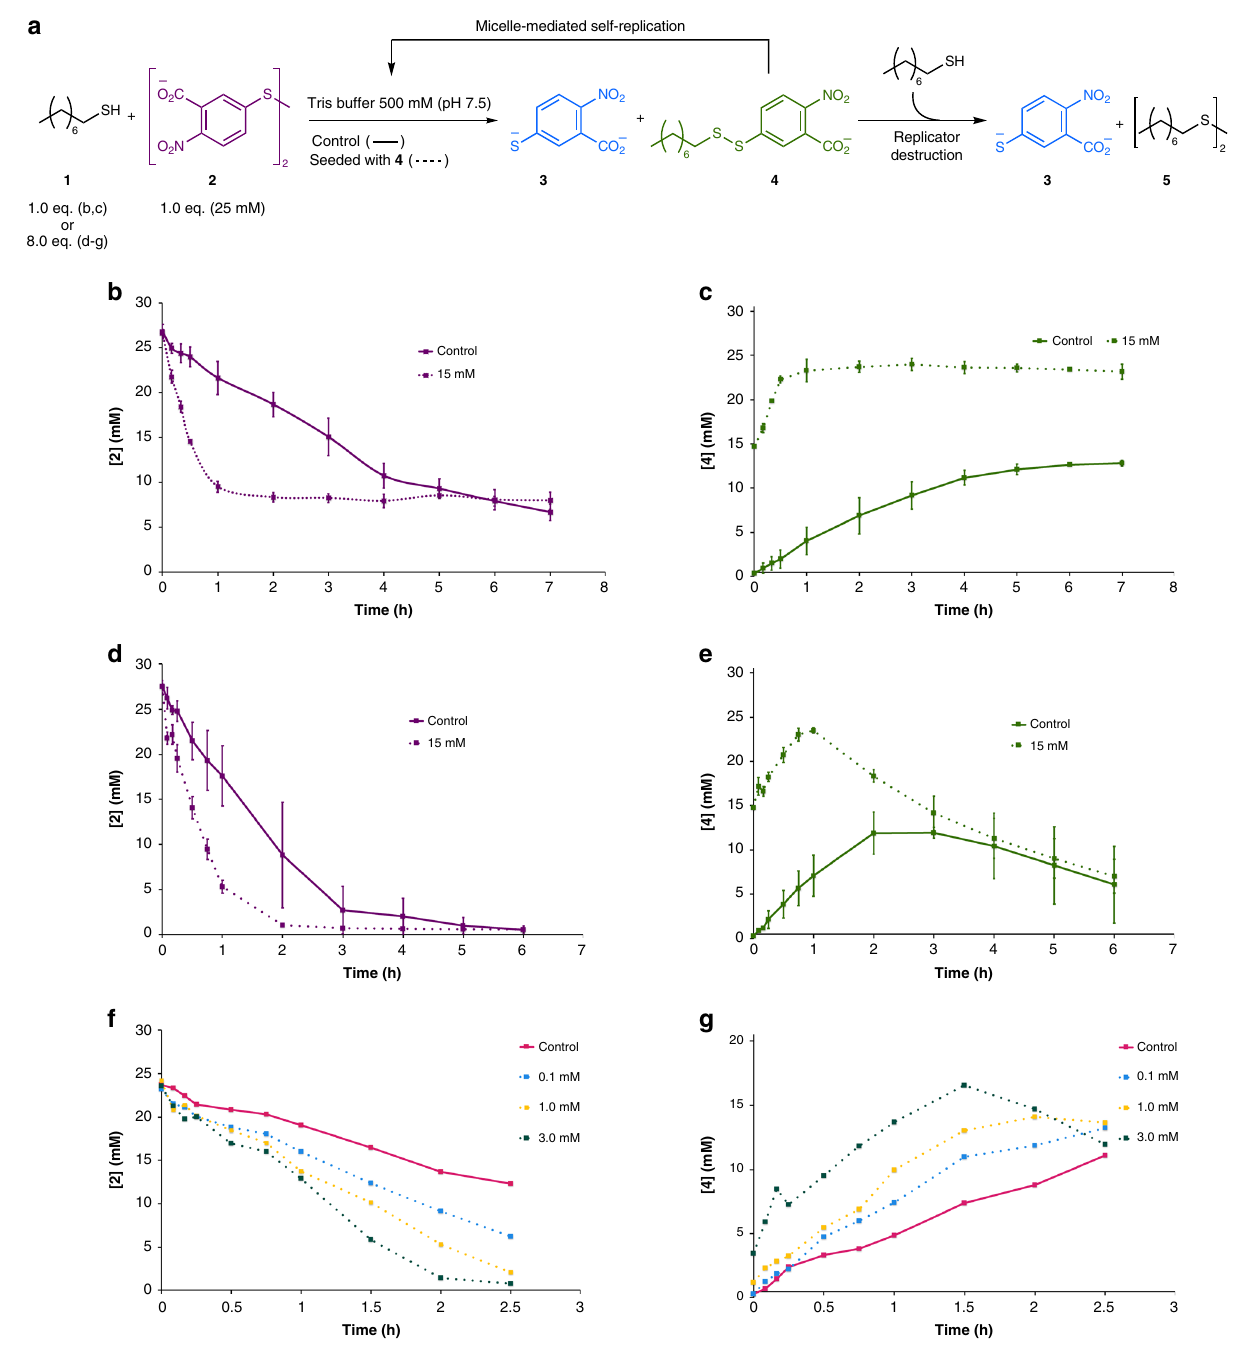
Fig. 3 Control and seeded reactions. a A series of control and seeded reactions were performed to demonstrate autocatalysis, with variation both in the concentration of seeded product 4 and the equivalents of octanethiol 1 . b , c Concentration of 2 and 4 (respectively) over the course of the reaction conducted with 1.0 equivalent of octanethiol 1 , under control (solid line) and seeded (15 mM 4 , dotted line) conditions. d , e Concentration of 2 and 4 (respectively) over the course of the reaction conducted with 8.0 equivalent of octanethiol 1 , under control (solid line) and seeded (15 mM 4 , dotted line) conditions. f , g Concentration of 2 and 4 (respectively) over the course of the reaction under control (solid line) and seeded (various concentrations 4 , dotted lines) conditions. The concentration of reaction components was monitored by UPLC. Each plotted point in b – e is the average of three reactions and the error bars represent the standard deviation. For f and g reactions were performed once